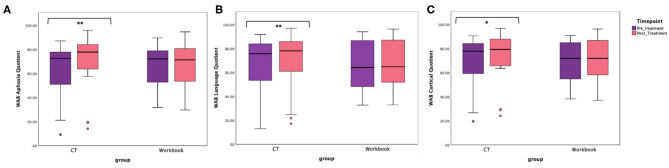
Unadjusted means for WAB-R (A) Aphasia Quotient, (B) Language Quotient, and (C) Cortical Quotient for the two groups (CT-R and workbook) pre-treatment and post-treatment. Significant differences are marked with *. *p < 0.05 and **p < 0.01.